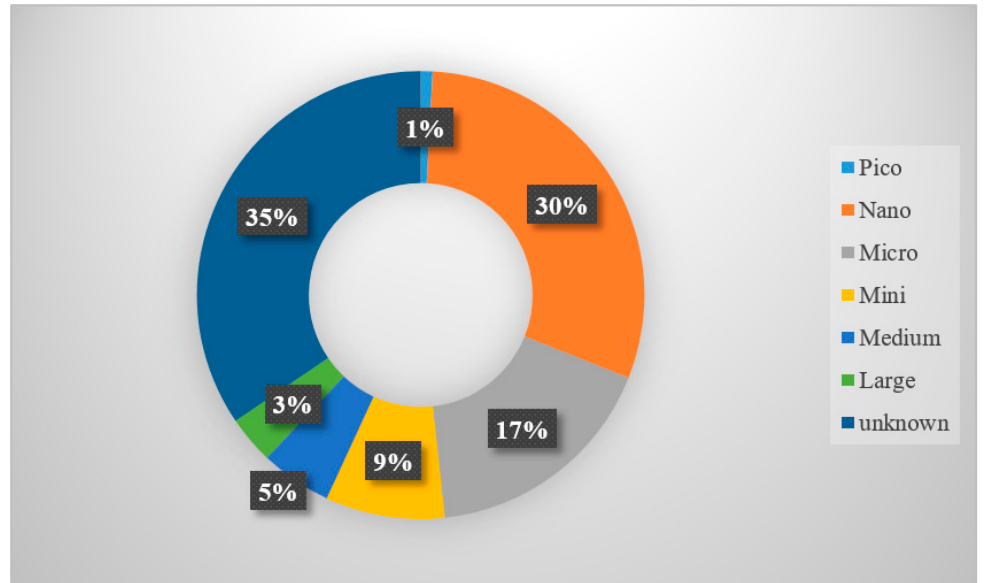
Figure 4. Constellations by satellite sizes: mass < 1 kg = pico; 1 kg < mass < 10 kg = nano; 10 kg < mass < 100 kg = micro; 100 kg < mass < 500 kg = mini; 500 kg < mass < 1000 kg = medium, mass > 1000 kg = large.